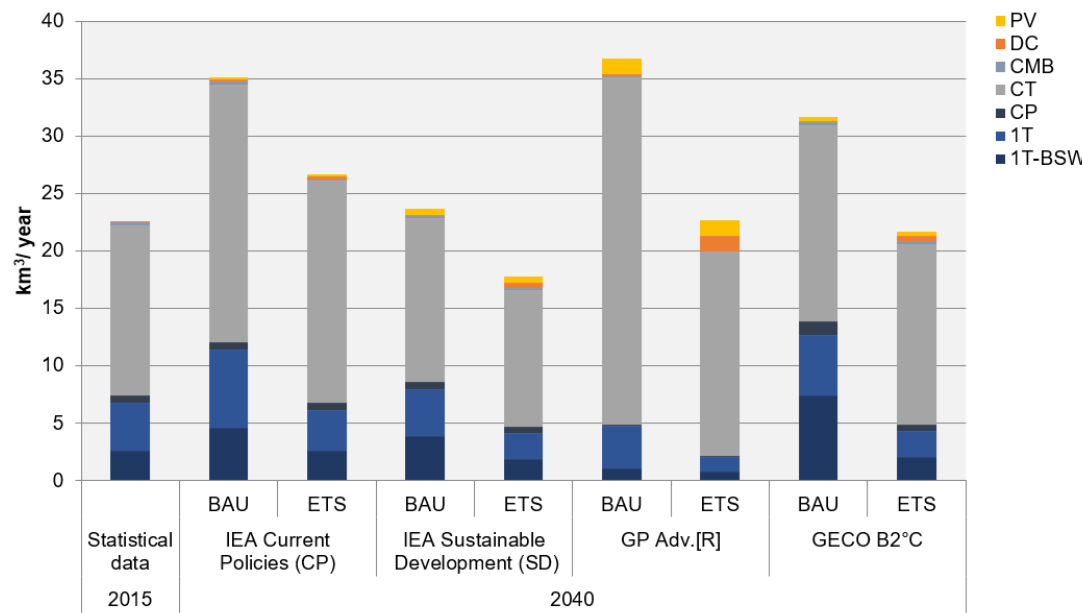
Figure 6. Water consumption for electricity generation (in km 3 per year, excluding hydropower) by cooling technology for 2015 and the four energy scenarios in combination with changes in the power plant type and cooling technologies (BAU and ETS scenarios) in 2040. Cooling systems: 1T-BSW = once-through with non-freshwater resources; 1T = once-through; CP = cooling pond; CT = cooling tower; CMB = combined-cooling system; DC = dry cooling; PV = photovoltaic (values for PV correspond to the water needs for cleaning and operation). (Source: own calculation based on the data from [39–41]).